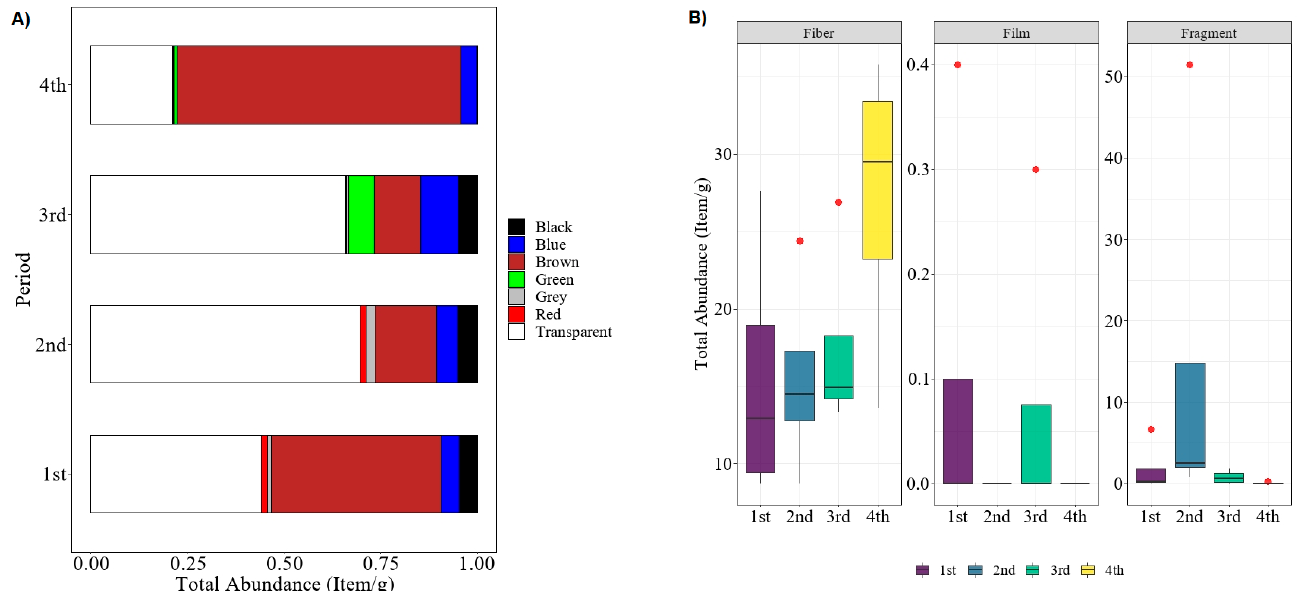
Figure 3. Total abundance of microplastic found in polychaete of sampling period 1 to 4: ( A ) based on color, ( B ) based on shape.